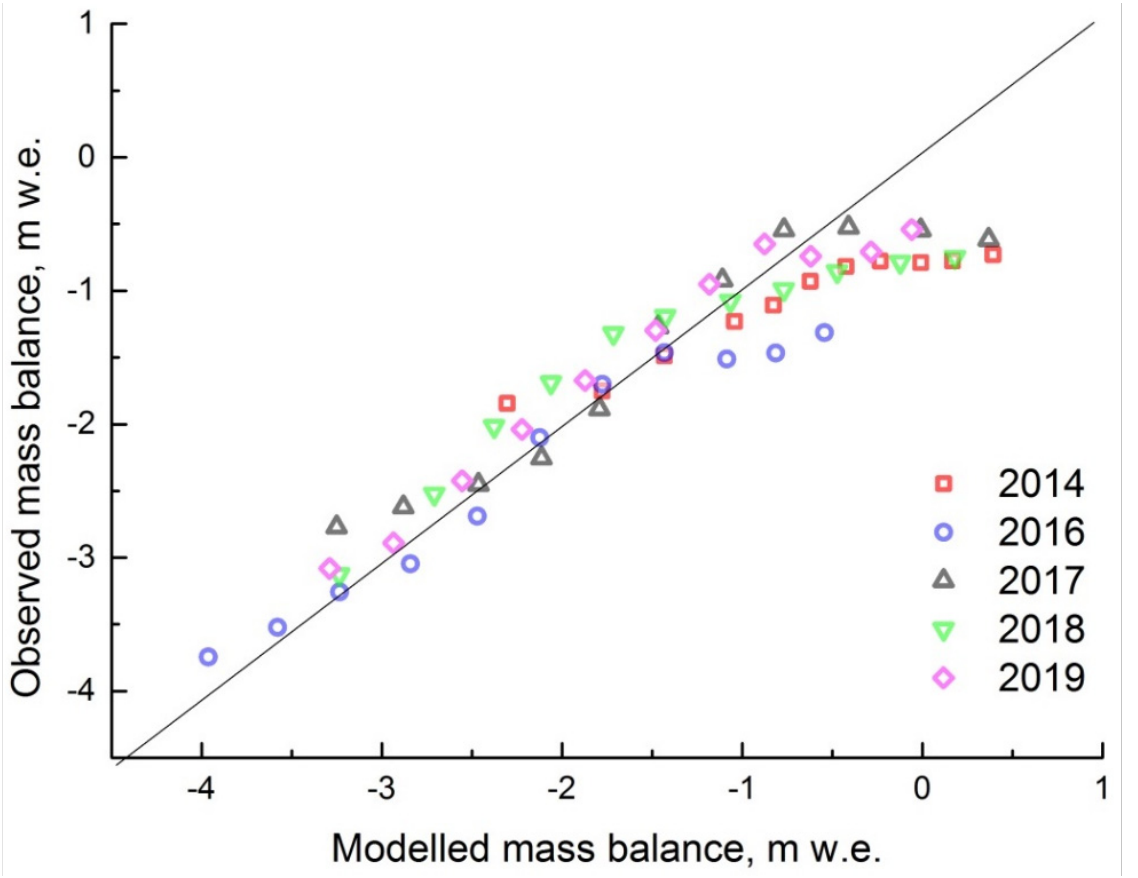
Figure 7. Comparison of modeled and observed annual mass balance for 5 years.